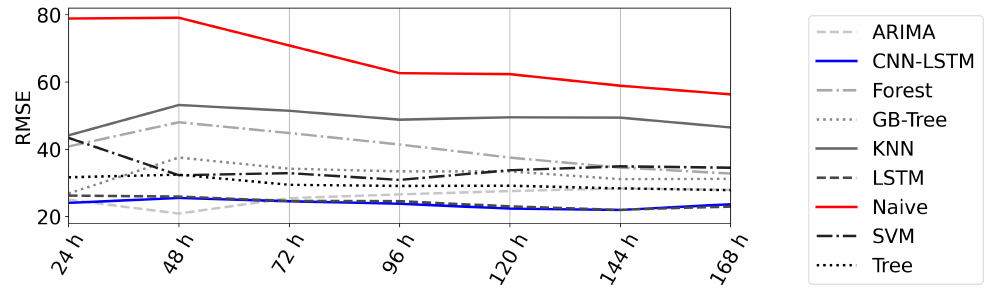
Figure 9. Model comparison over time for test scenario 3.